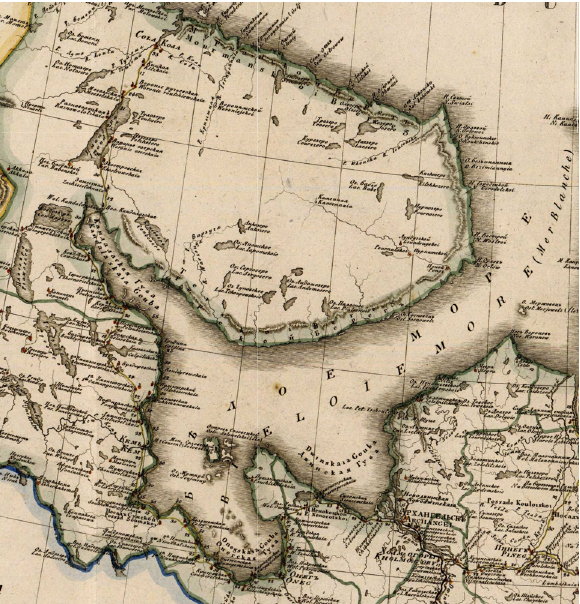
Figure 3. Map of Arkhangelsk Governatorate in 1824 (close-up). Stations on the mail delivery road and distances between them are indicated. Both winter and summer roads are shown (www.kolamap. ru). Site locations are accurate to within 5